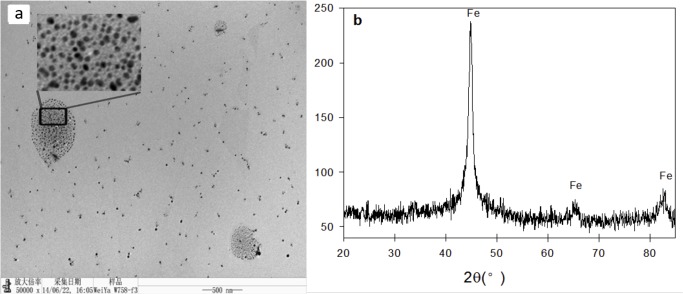
TEM (a) and XRD (b) analyses of NZVI.